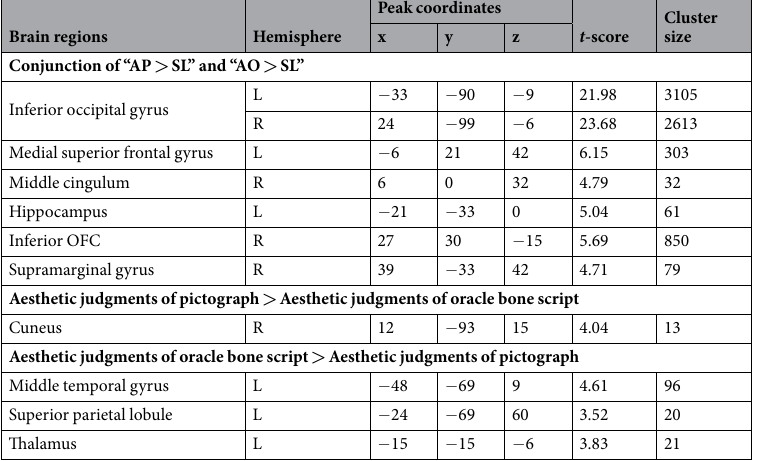
adopted the square luminance judgment task as a baseline task to control for the activation of motor-related areas in response to key pressing, we infer that visuo-spatial exploration and motor representation may be associated with aesthetic orientation. More precisely, these motor-related regions may be implicated in the generation of embodied approach and motivation for beauty, and the above neural results could be interpreted as indicating that beauty judgments of pictographs involve joint participation of perceptual processing, cognitive judgment, reward and embodied experience 21, 28, 29 . For both the aesthetic judgments overall and beautiful judgments specifically of oracle bone scripts, neuro- imaging results revealed similar neural regions including bilateral inferior occipital gyri, bilateral inferior frontal gyri, left medial superior frontal gyrus, and bilateral hippocampus. We also found the right inferior OFC was active regardless of aesthetic valence, and the right putamen was active for beauty judgments of oracle bone scripts that referred to positive social meanings. Although no activation in the inferior OFC was found in the analysis with aesthetic valence, the putamen has been strongly implicated in reward process 19, 50–53 . As hypoth- esized, our results are consistent with previous neuroaesthetics findings, and could be interpreted as that beau- tiful judgments of oracle bone scripts referring to positive social meanings also commonly rely on perceptual,